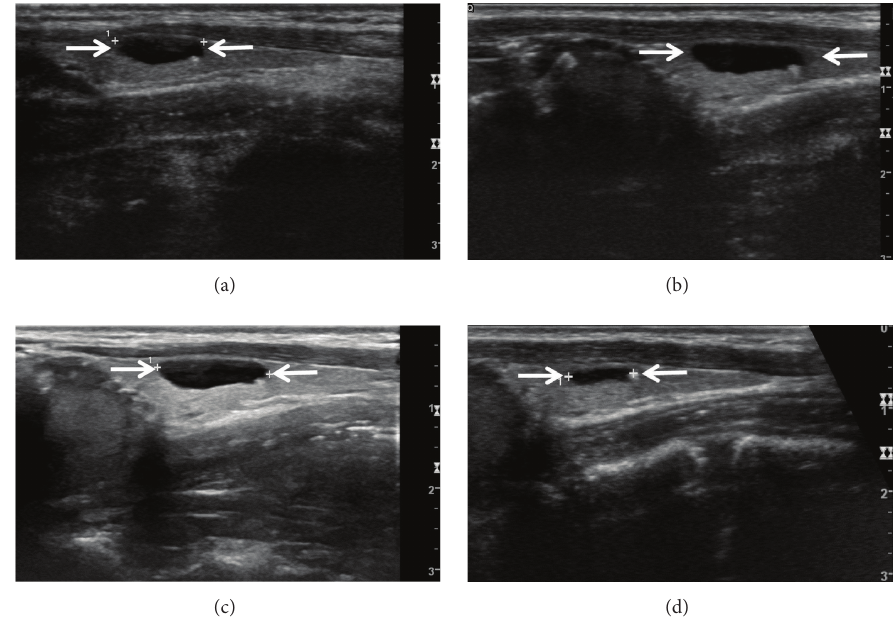
Figure 2: A thyroid colloid cyst with positive fluctuation in a 40-year-old woman. Longitudinal sonogram (a) shows a colloid cyst with an anechoic nodule and a comet-tail artifact in the left thyroid lobe (arrows, 11.1mm at its largest diameter). Upon sequential US follow-ups, this colloid cyst demonstrates a gradual increase at a 1-year (b) (arrows, 13.0 mm at its largest diameter) and a 2-year (c) (arrows, 13.8mm at its largest diameter) US follow-ups, but it shows a moderate decrease on 3-year follow-up US (d) (arrows, 8.4 mm at its largest